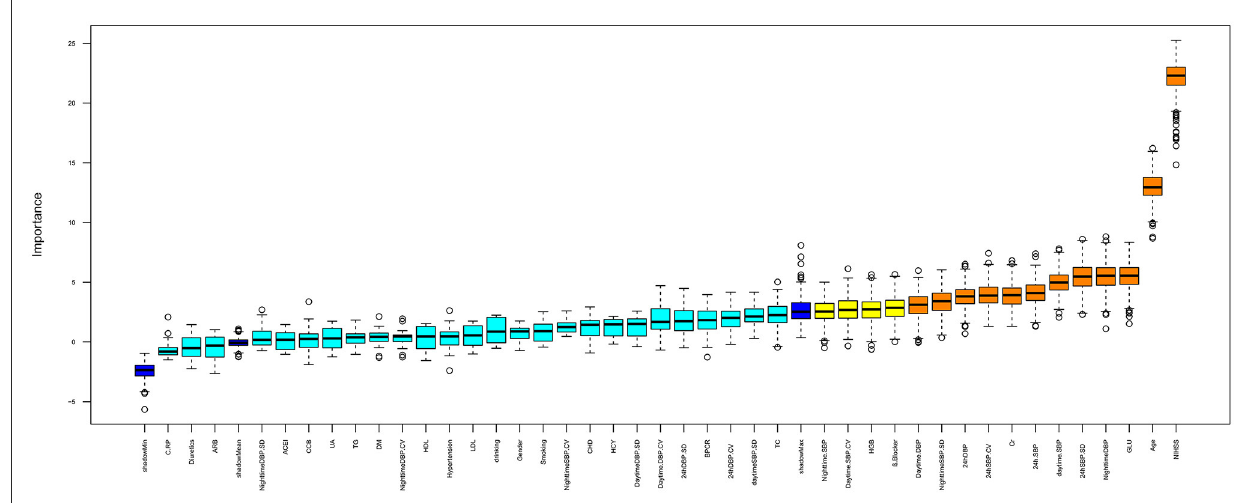
FIGURE2 Important feature selection by random forest. The plot displays all the features leading up to the stroke. Important variables are in orange boxes, rejected variables are in cyan boxes, and tentative variables are in yellow boxes.